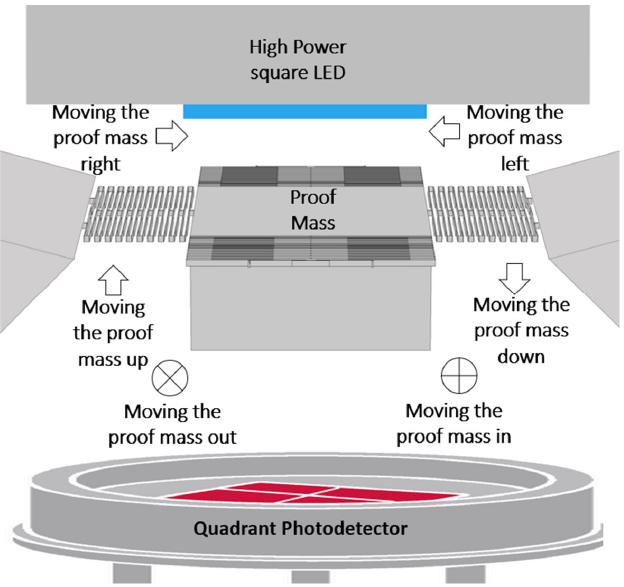
Figure 1. A schematic describes the proposed optical accelerometer working mechanism and parts. The dimensions are not to